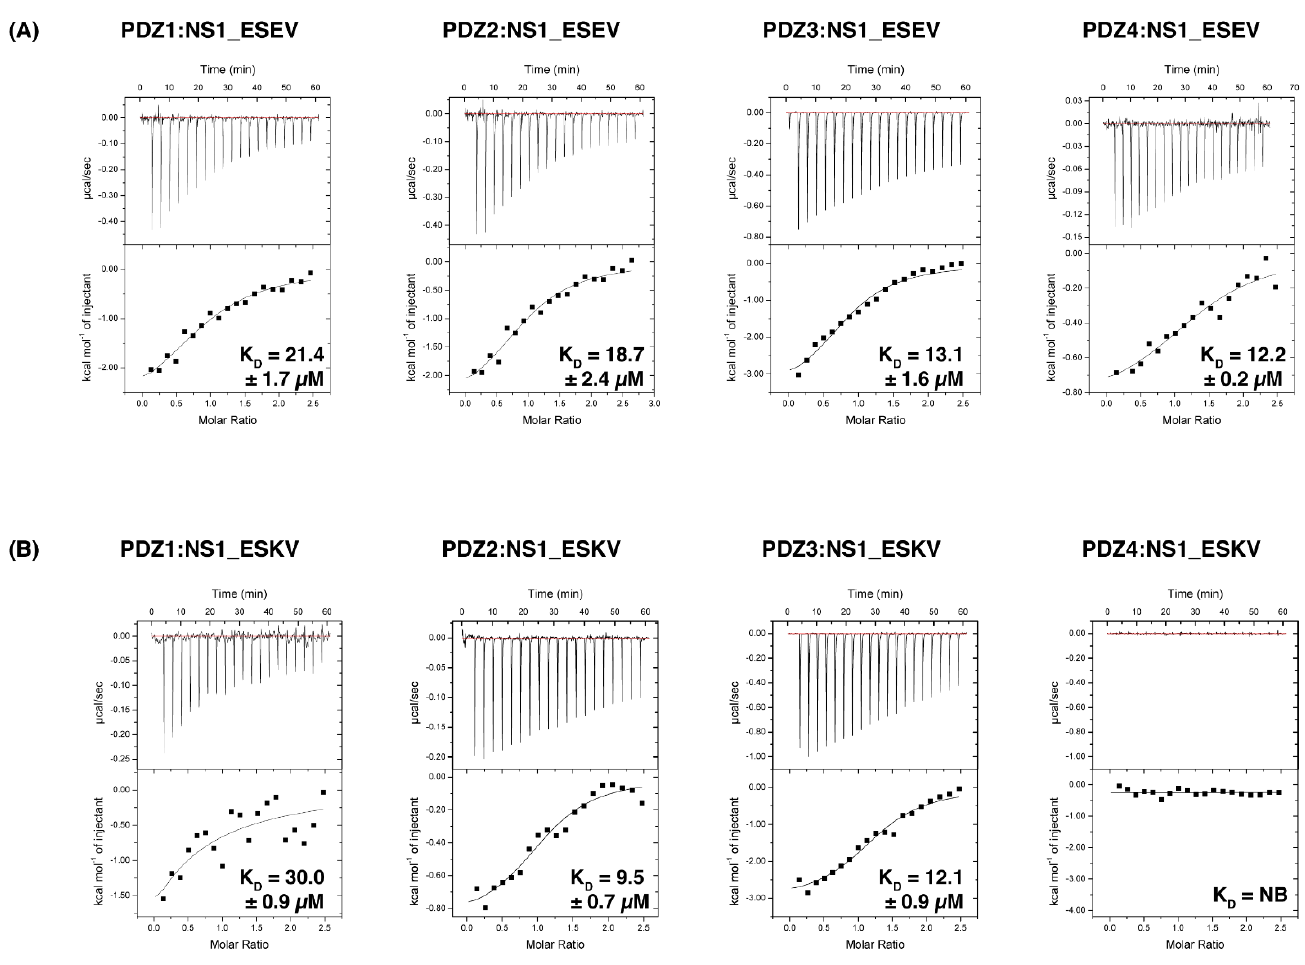
Figure 2. Interactions of the Scribble PDZ domains with NS1 PBM peptides. ( A ) SCRIB individual PDZ domains with NS1 ESEV PBM peptides. ( B ) SCRIB individual PDZ domains with NS1 ESKV PBM peptides. Affinities were measured using isothermal titration calorimetry (ITC) and the raw thermograms are shown. K D values (in μ M) are the means of 3 experiments ± SD.